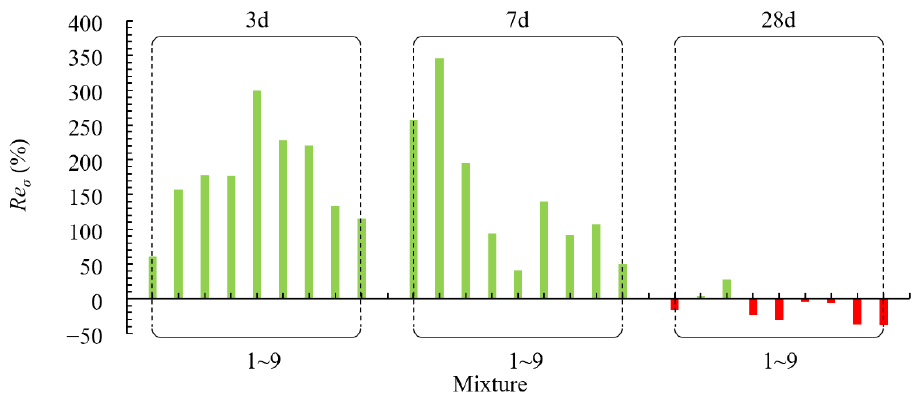
Figure 7. Re σ of RSCPB for 3 days, 7 days, and 28 days curing ages.